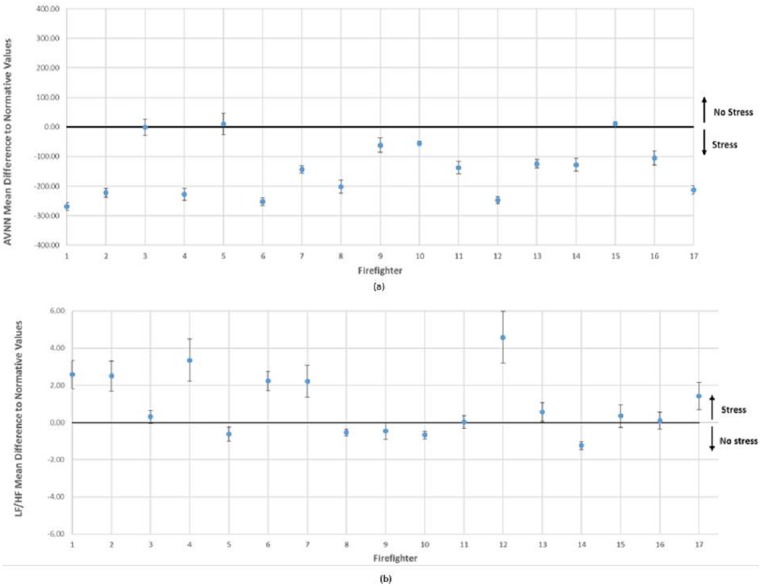
Differences between (A) AVNN and (B) LF/HF obtained during entire shifts and normative values for each subject, individually controlling against baseline HRV for age and gender (Voss et al., 2015).